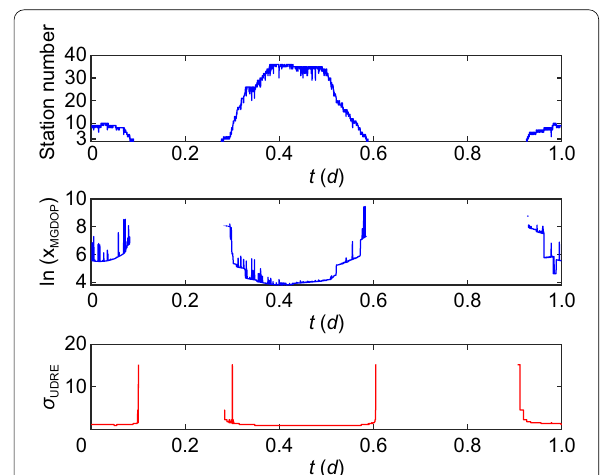
Fig. 2 Relationship between ln ( x MGDOP ) and WAAS-reported σ